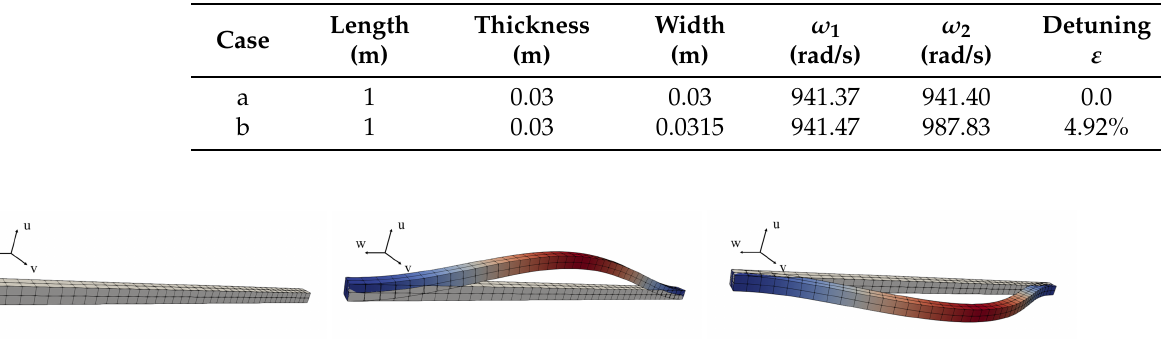
Table 1. Dimensions and eigenfrequencies of the clamped beams with and without detuning, where ε = ( ω 2 − ω 1 ) / ω 1 .